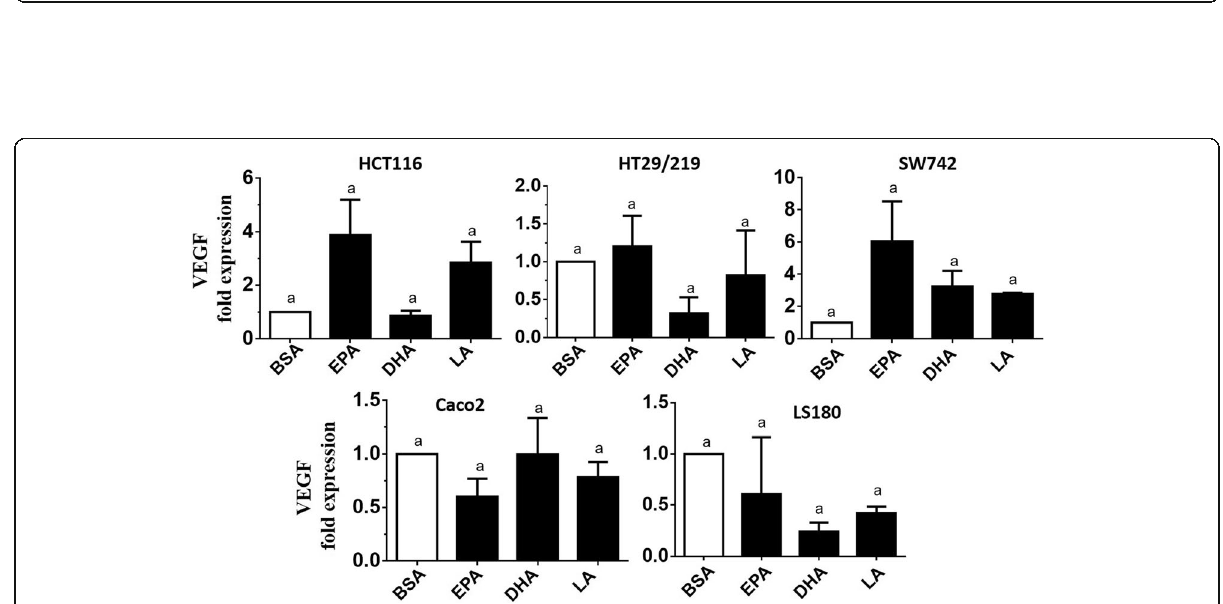
Fig. 3 Comparison of the relative expression of VEGF in PUFA-treated and control cells, measured by quantitative real-time-PCR. Expression of VEGF was normalized to GAPDH. BSA-treated cells were used as a control and expressions in all other PUFA-treated cells were expressed as an n -fold difference relative to controls (BSA). Mean values ± SD of the three experiments are given, and data are verified by Tukey ’ s honestly significant difference multiple comparison test ( p > 0·05). EPA, eicosapentaenoic acid; LA, linoleic acid; DHA, docosahexaenoic acid; BSA, bovine serum